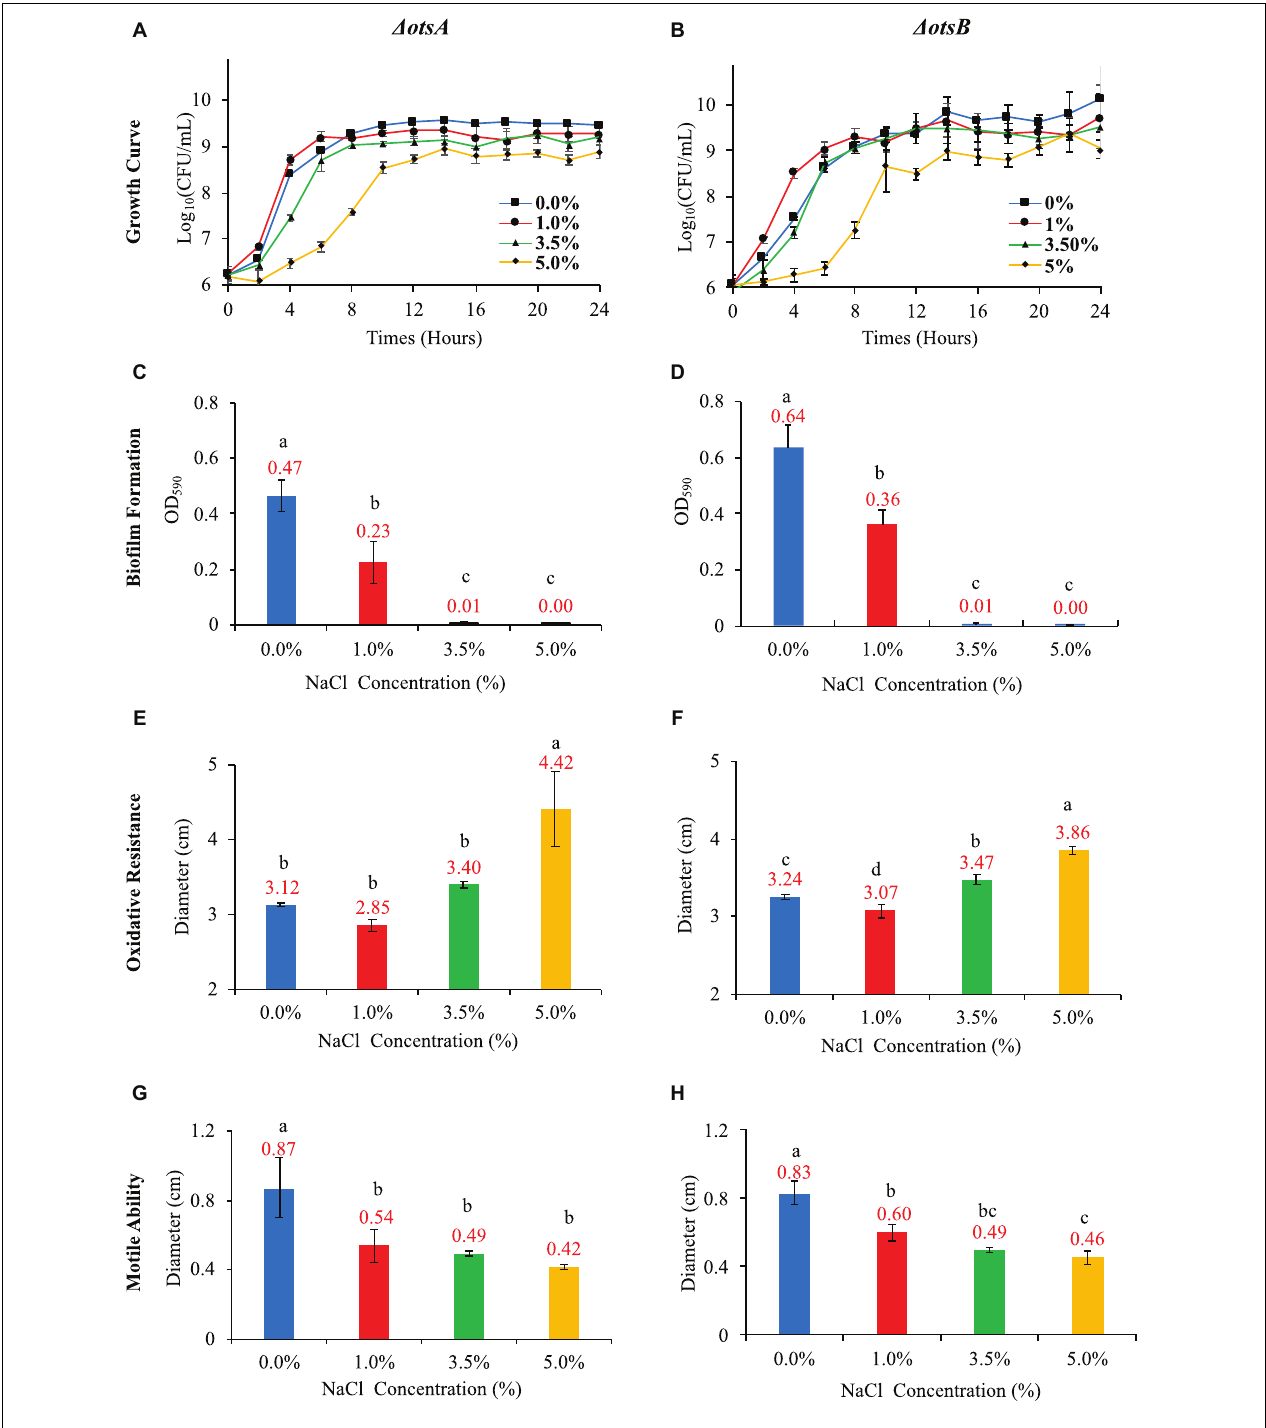
FIGURE 5 | Effects of NaCl on growth rate, biofilm formation, oxidative resistance, and motile ability in E. coli (cid:49) otsA and (cid:49) otsB . (A,B) Effects of different NaCl concentrations on the growth rates of E. coli mutants. (C,D) Effects of different NaCl concentrations on E. coli mutant biofilm formation. (E,F) Influences of different NaCl concentrations on the oxidative stress resistance of E. coli mutants. (G,H) Effects of different NaCl concentrations on E. coli mutant motile abilities. Tukey’s Honestly Significant Difference (HSD) test was performed, which compared the means of every group to the means of every other group simultaneously. Means denoted by a different letter indicated significant differences among groups ( P -value <